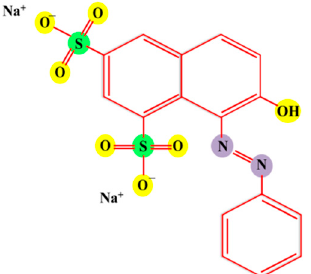
Figure 1. Molecular structure of ORG dye.